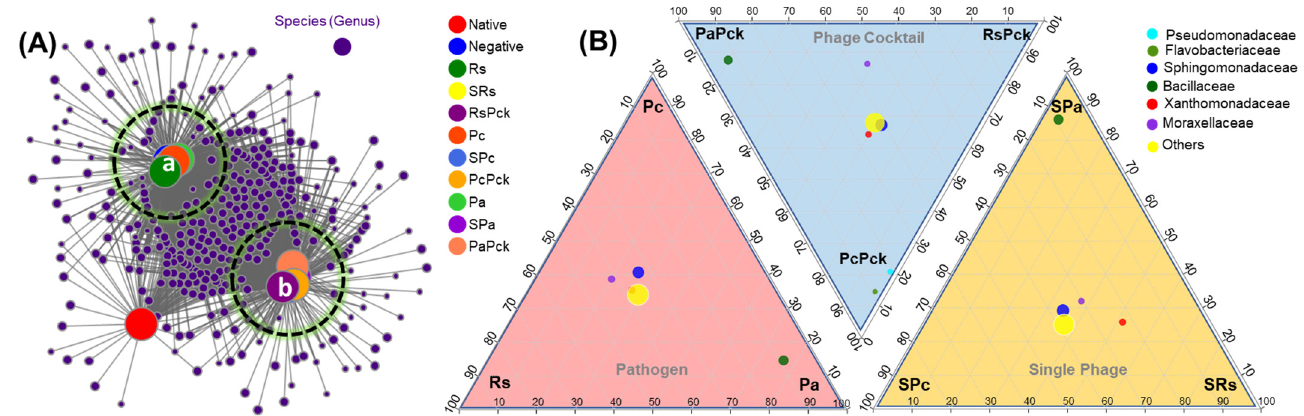
Figure 4. ( A ) Bacterial co-occurrence networks between single, phage cocktail and pathogens for the three phage therapy experiment (a: cluster of the negative, and pathogen treated samples, and b: cluster of phage treated samples) compared to an uncultivated soil sample (native). ( B ) Three triangular comparisons at the family level among the different pathogens (Rs, Pc and Pa), phage cocktails (RsPck, PcPck and PaPck), and single phages (SRs, SPc and SPa) are shown.